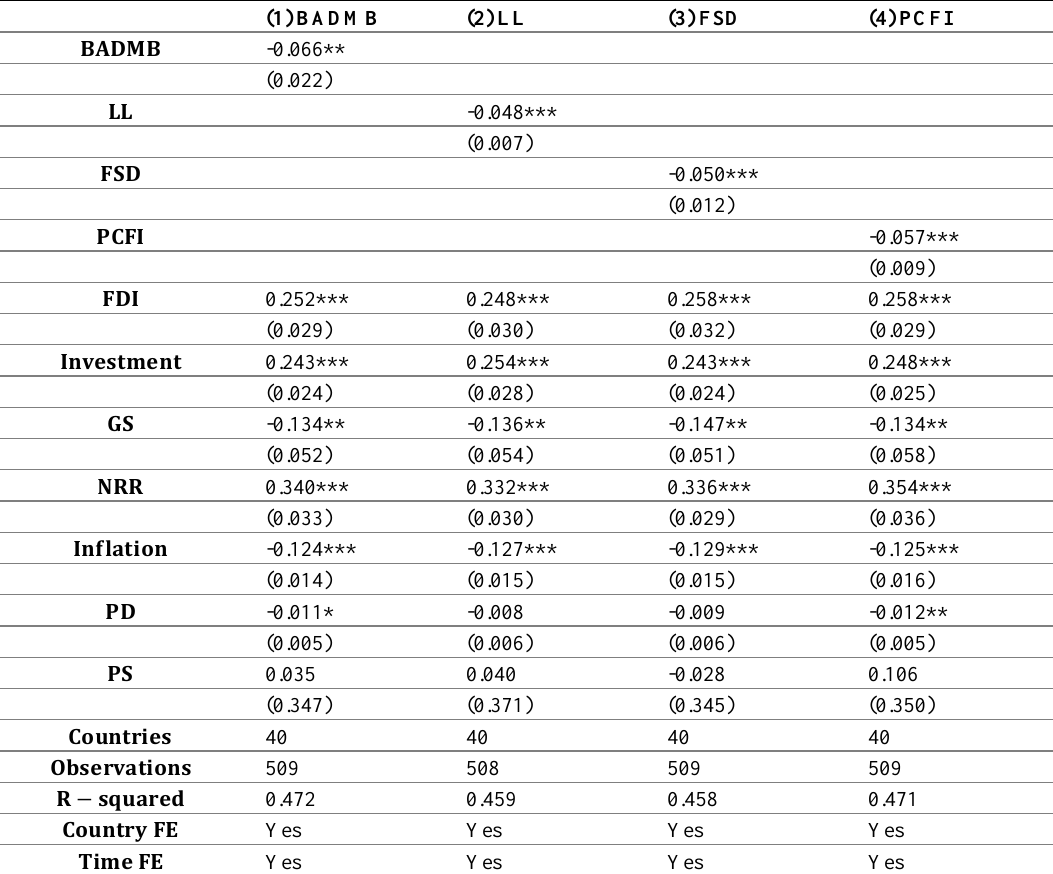
Table 3: Alternative Measures of Financial Depth